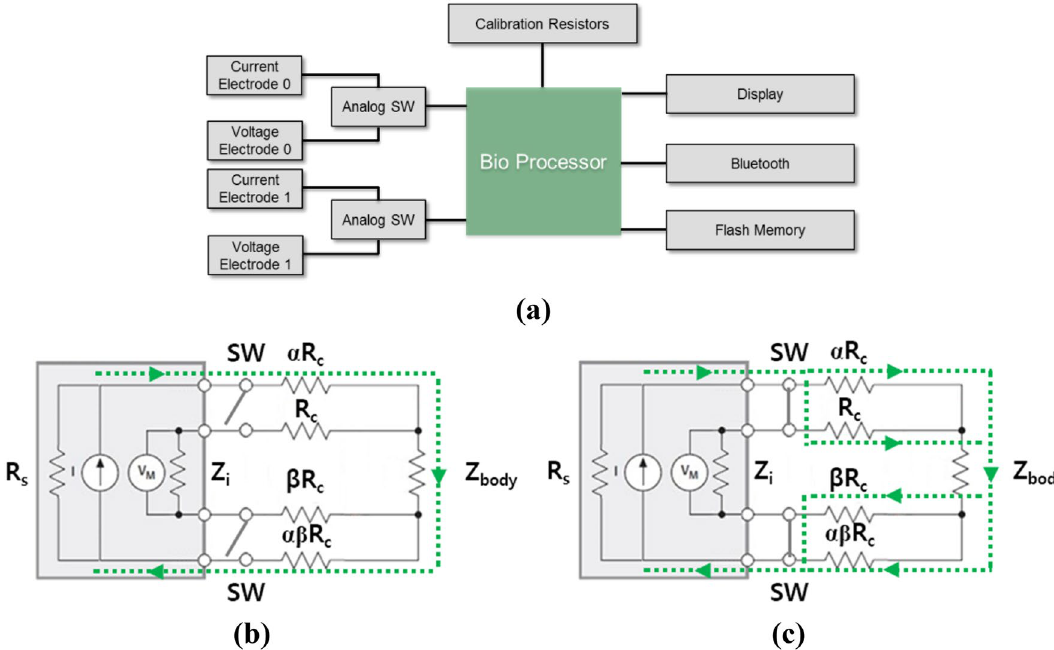
Figure 4. ( a ) Hardware block diagram of the overall system, ( b ) current path for 4-point measurement mode, and ( c ) current path for 2-point measurement mode. Z body measured impedance, Z i input impedance of